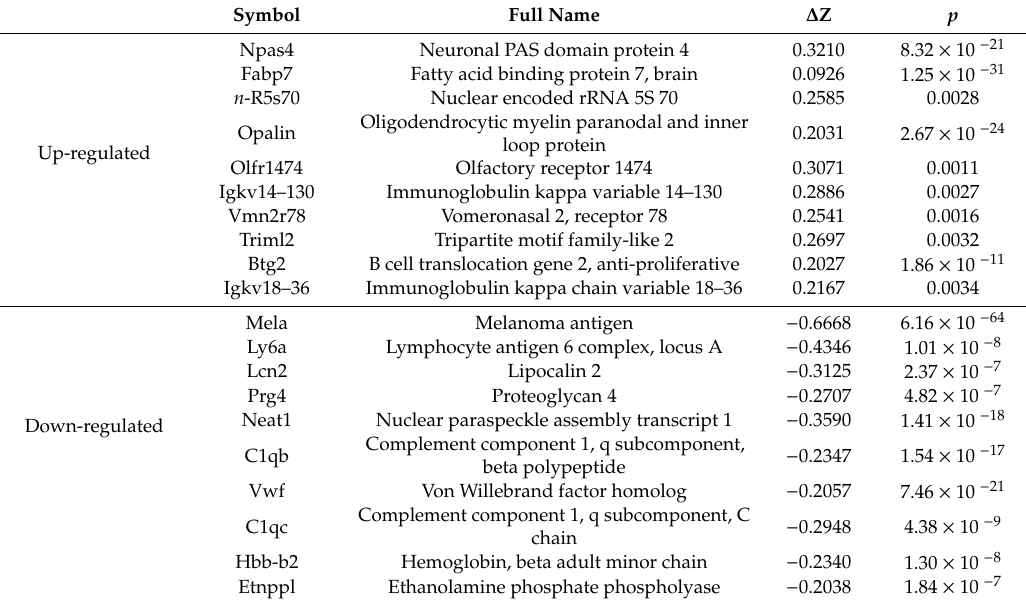
Table 2. Top 10 genes that were significantly up or down-regulated following theanine